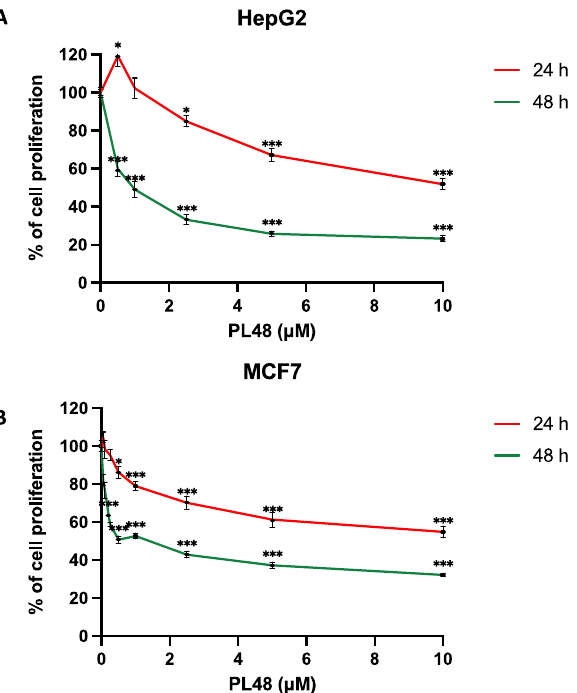
Figure 4. Effects of PL48 inhibitor on ( A ) HepG2 and ( B ) MCF7 cell proliferation. Cells growing in the log phase were incubated with MEM (HepG2) or RPMI-1640 (MCF7) in the presence or absence of PL48 at concentrations of up to 10 µM for 24 or 48 h. Cell number was determined by crystal violet staining and expressed as a percentage of the control cells. These experiments were performed twice in triplicate. * p < 0.05, *** p < 0.0001.